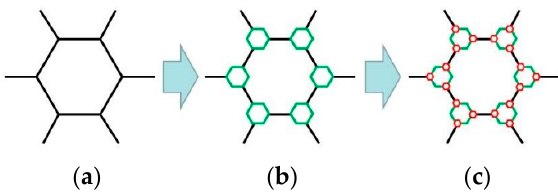
Figure 5. Unit cell of an evolved honeycomb: ( a ) the original cell; ( b ) the first order; and ( c ) the second order. Nanomaterials 2018 , 8 , x FOR PEER REVIEW